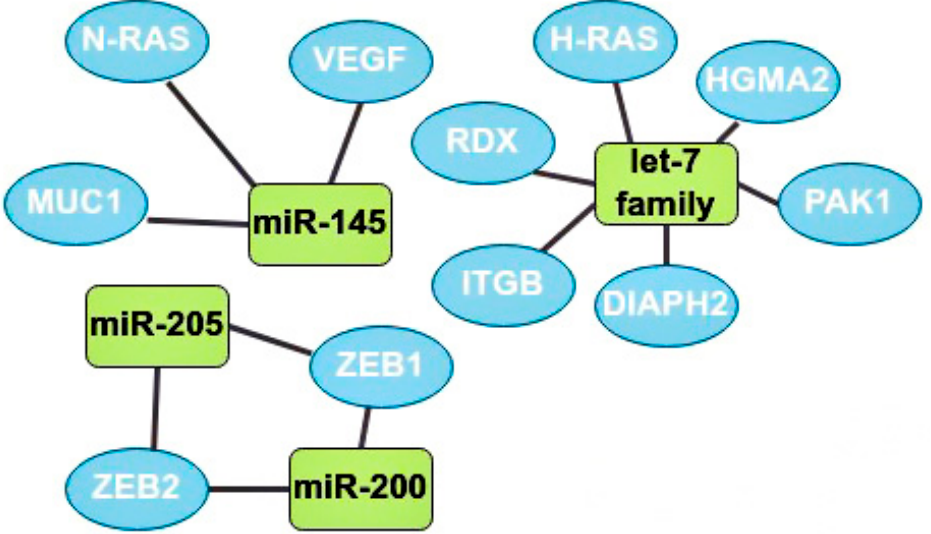
Figure 5. The most studied oncosuppressors and their target genes. MiR-145 has 3 target genes: neuroblastoma RAS viral oncogene homolog (N-RAS), MUC1, and vascular endothelial growth factors (VEGF). Let-7 family target genes: radixin (RDX), Harvey rat sarcoma viral oncogene homolog (H-RAS), high-mobility group AT-hook 2 (HGMA2), serine/threonine-protein kinase (PAK1), diaphanous-related formin 2 (DIAPH2), and integrin subunit beta (ITGB). MiR-205 and miR-200 have 2 mutual target genes: zinc finger E-box binding homeobox 1 and 2 (ZEB1, ZEB2).